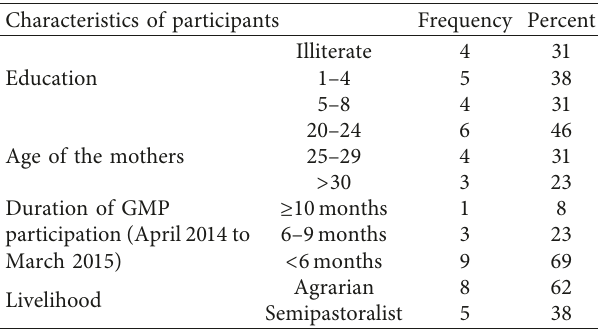
Table 1: Characteristics of mothers of under-two children involved in in-depth interview from 13 kebeles of Loka Abaya district, Southern Ethiopia, 2015 ( N �